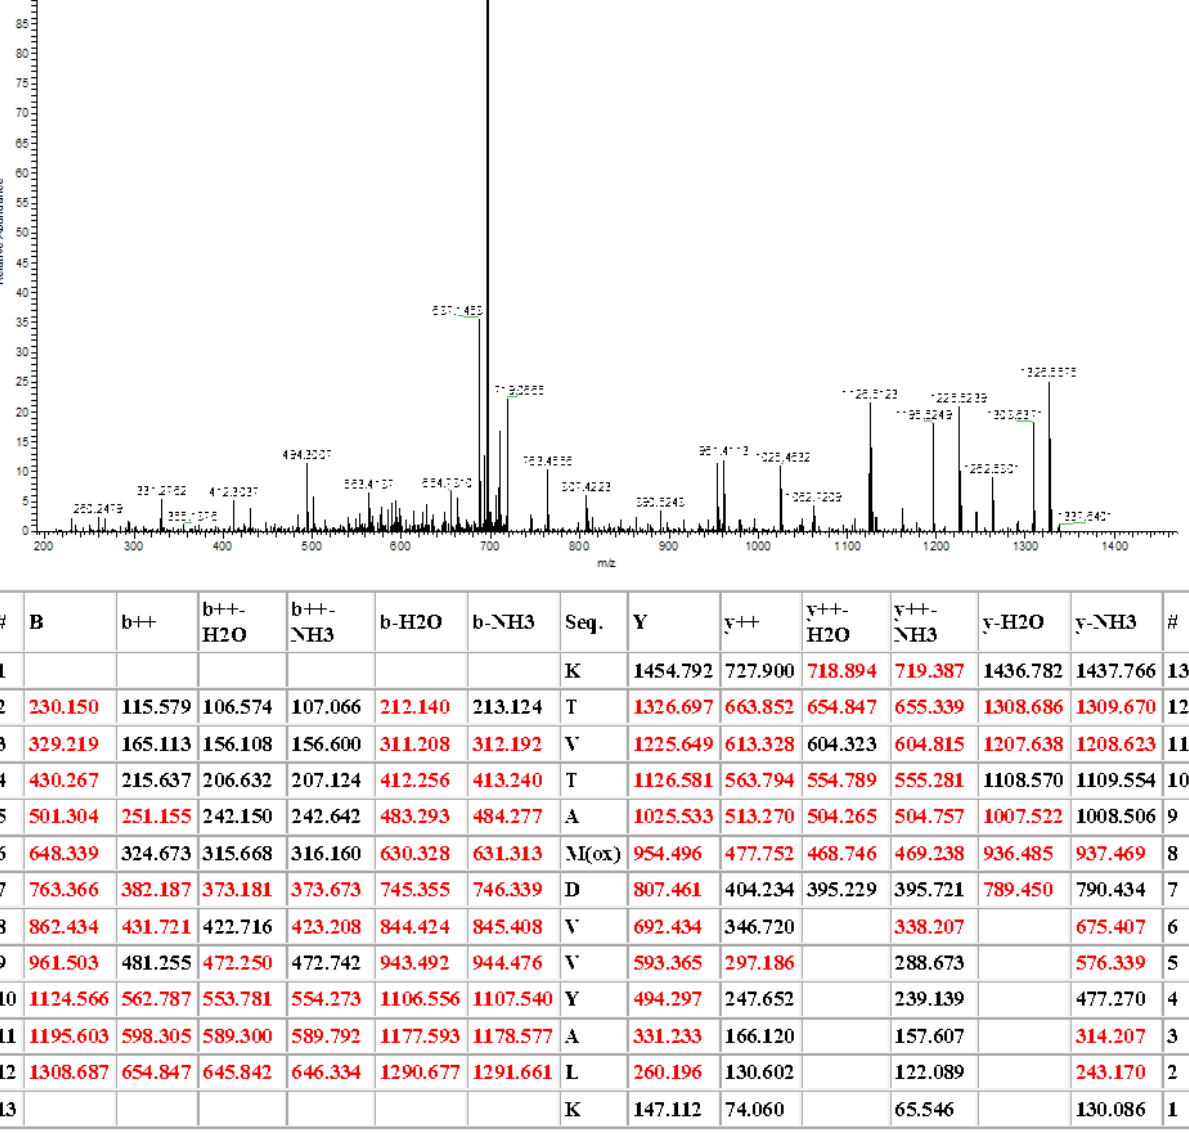
possibility that these structures could represent particles formed by the concurrent activity of